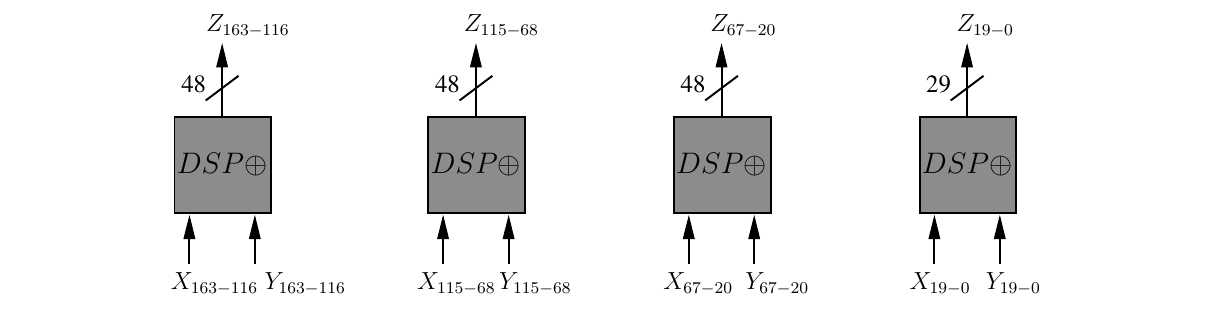
Figure 5. Organization of the proposed B-163